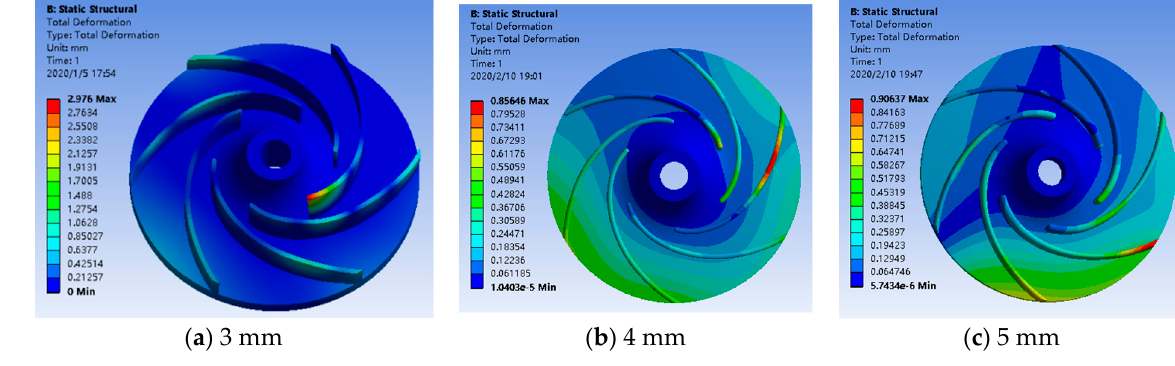
Figure 8. Strain distribution of impeller.